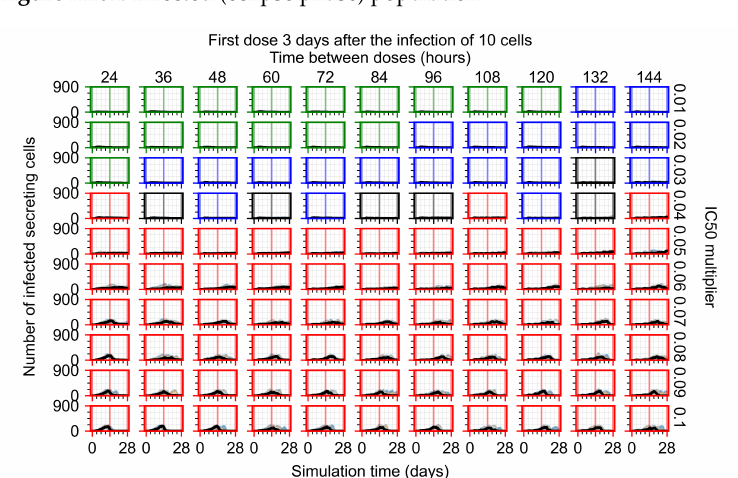
Figure A101. Infected (eclipse phase) population.